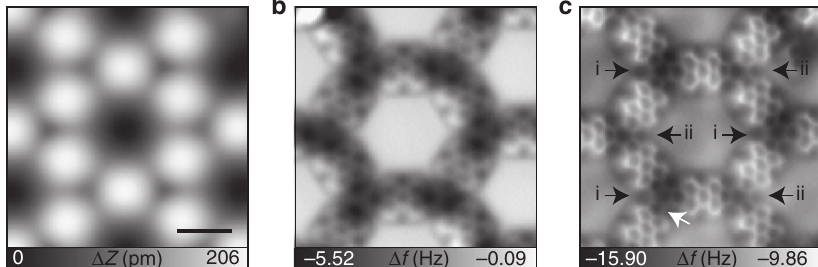
Figure 2 | Atomic scale observation. ( a ) STM topography and ( b ) AFM images taken with a Xe-functionalized tip and ( c ) a CO-functionalized tip. The two symmetry-inequivalent nodal sites are indicated as i and ii; the five-membered C 3 N 2 of the 3deh-DPDI exo-ligands are indicated by a white arrow. Measurement parameters: I ¼ 2pA and V ¼ (cid:2) 200mV in a , and A ¼ 60pm and V ¼ 0mV in b , c . Scale bar,